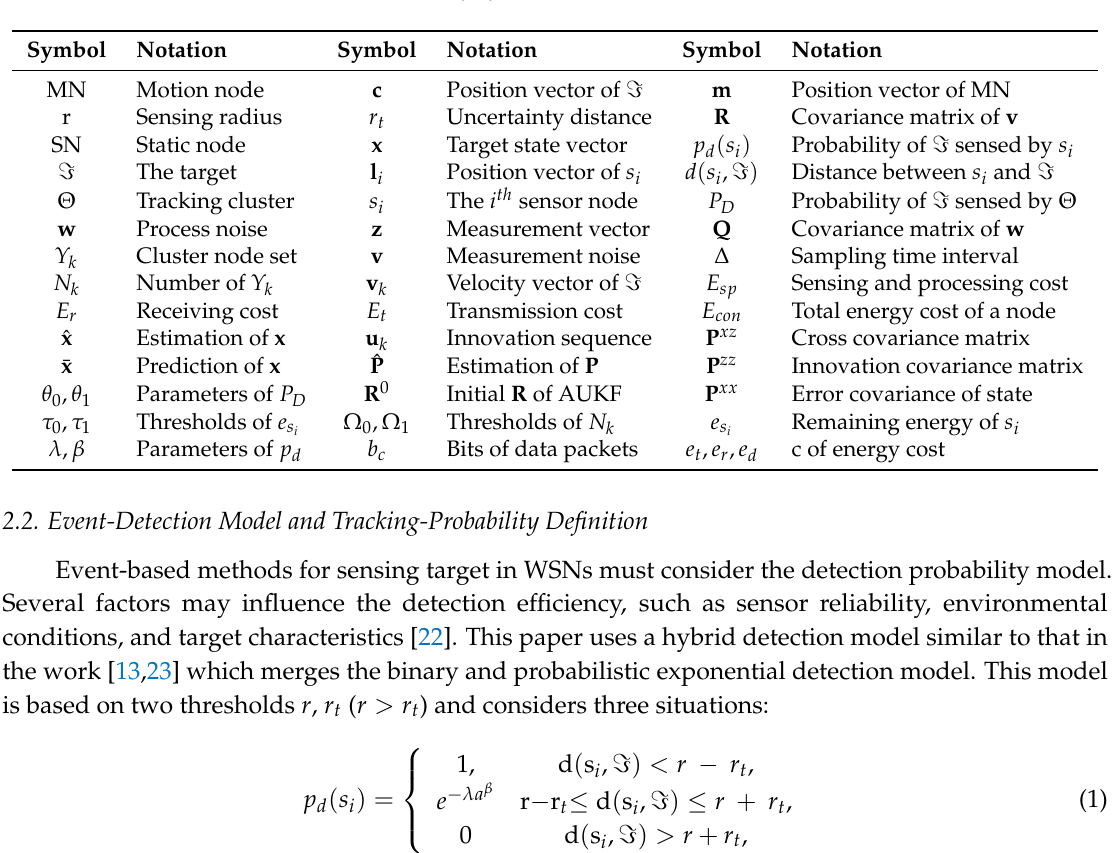
Figure 1. A moving target tracking scene in a wireless sensor network. Table 1. Key symbols and their